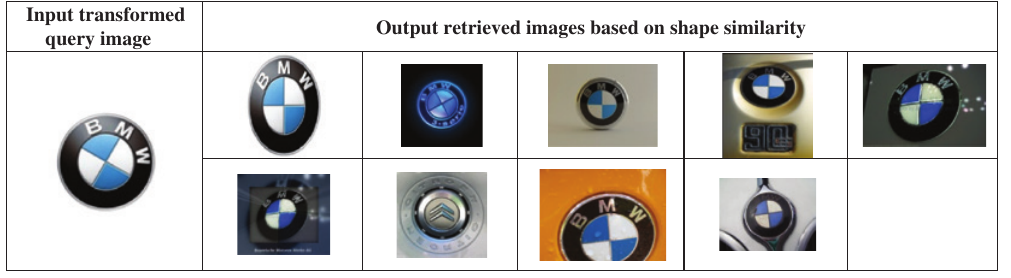
Table 4: Final Output Retrieved Images Based on Shape Similarity.